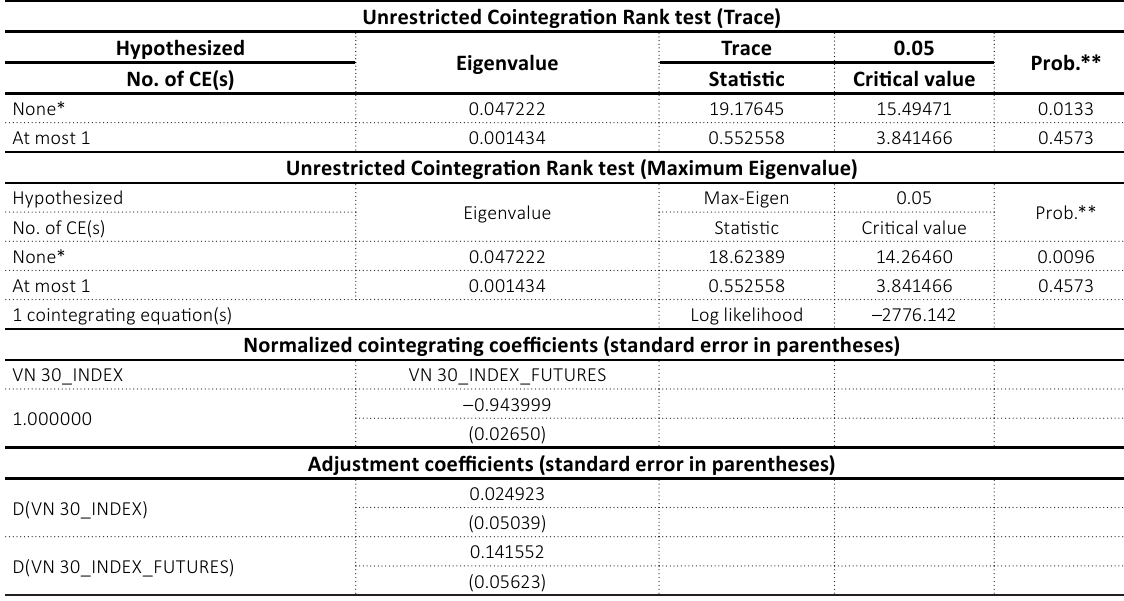
Source: Results calculated from EViews software.